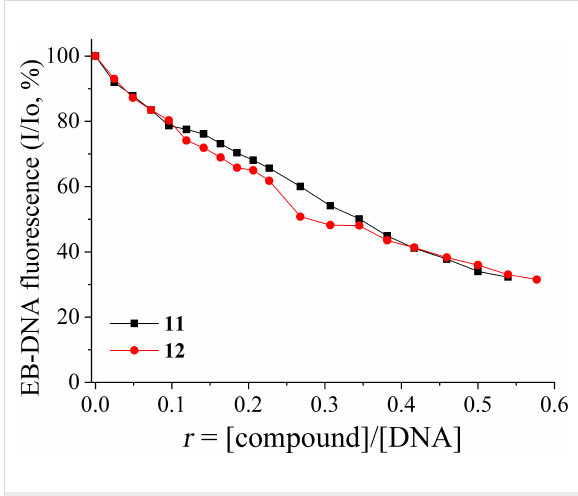
Figure 4: Plot of EB-DNA relative fluorescence emission intensity at λ = 592 nm ( I / I 0 , %) vs r (= [compound]/[DNA]) in the presence of com- pounds 11 and 12 (up to 32.3% of the initial EB–DNA fluorescence in- tensity for 11 and 31.5% for 12